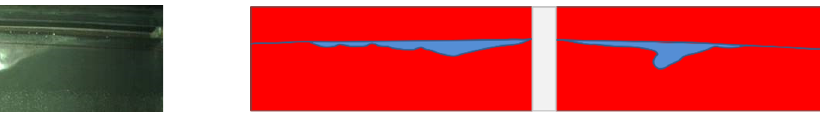
Figure 8. Oil entrapment photos.